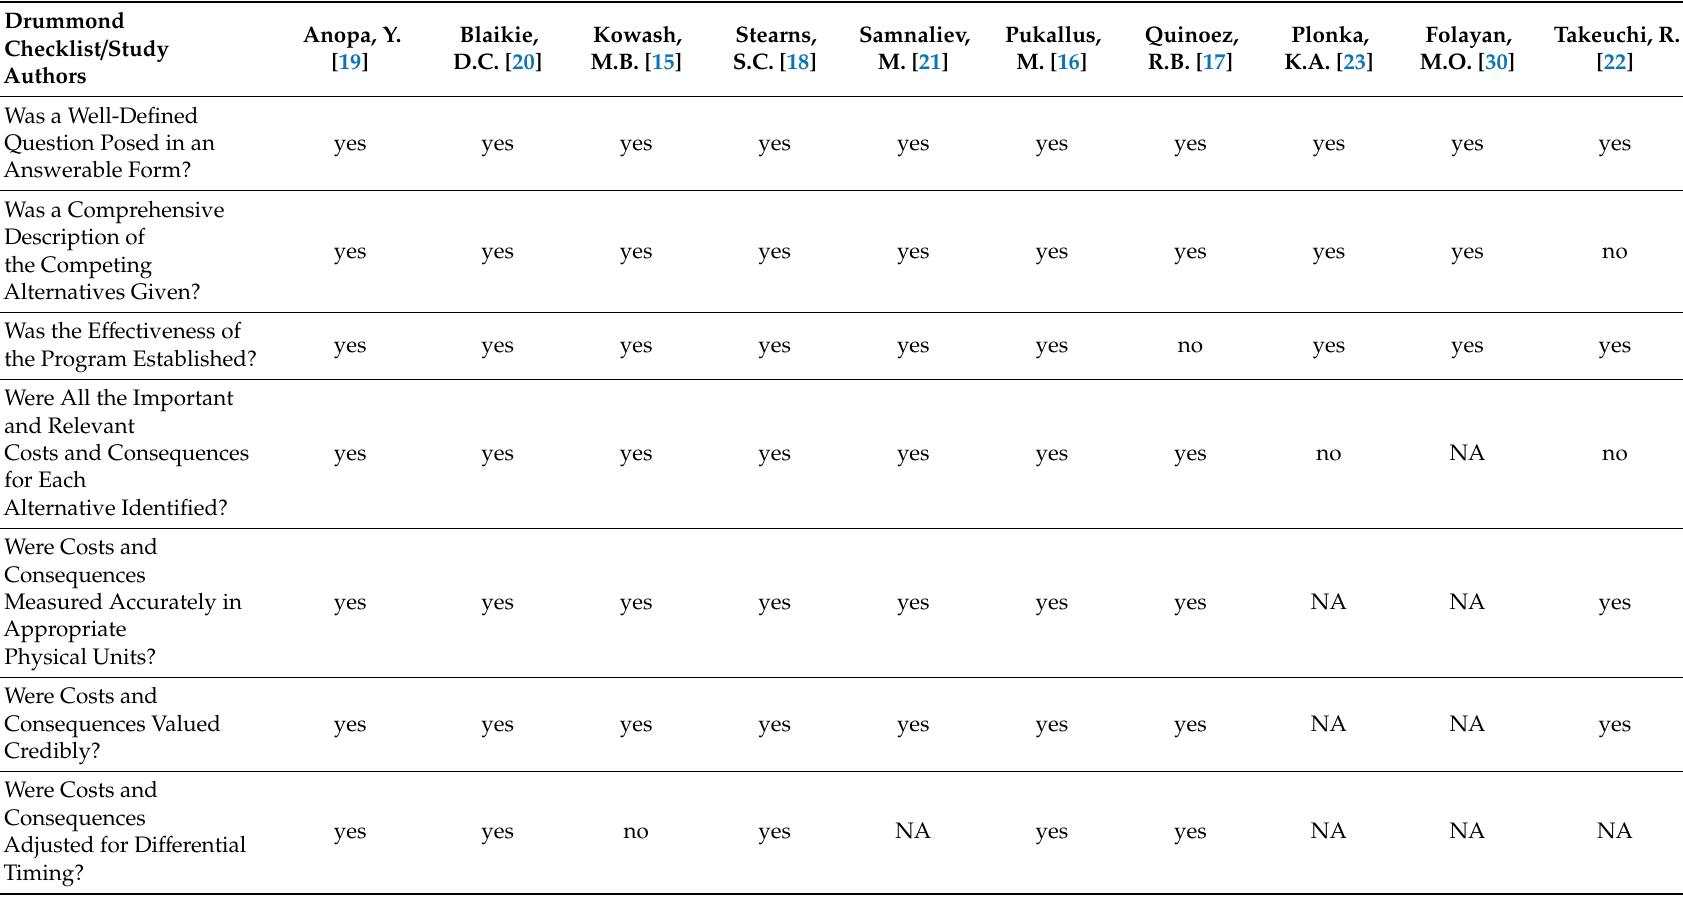
Table A3. The Drummond checklist for the risk of bias assessment of the trial-based economic evaluation